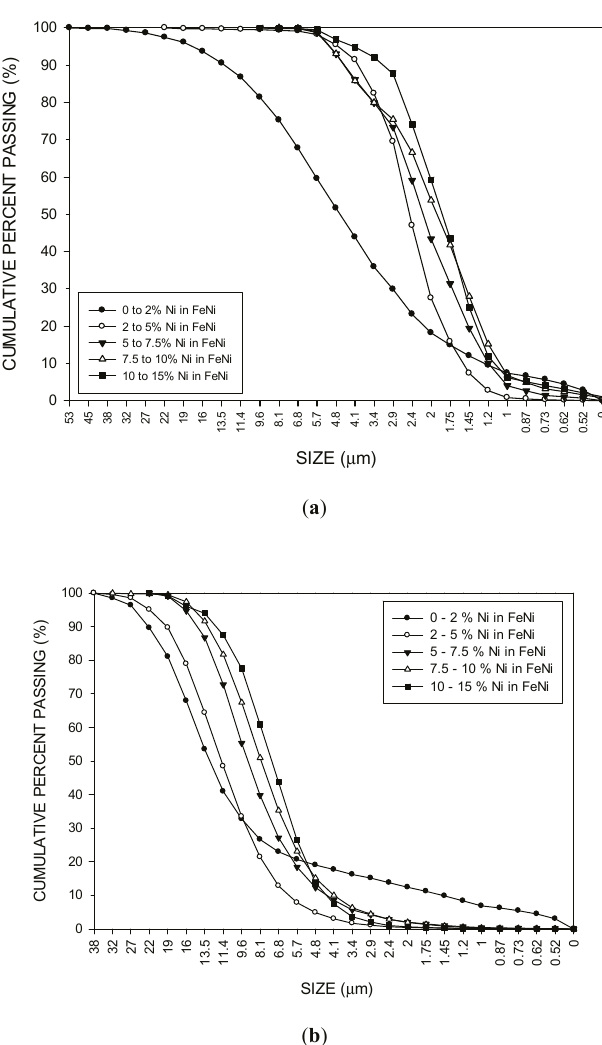
Figure 14. ( a ) Results of the MLA studies showing the cumulative percent passing as a function of particle size for various nickel grade ranges for the briquette containing 6% coal; ( b ) Results of the MLA studies showing the cumulative percent passing as a function of particle size for various nickel grade ranges for the briquette containing 6% coal plus 4% sulphur.